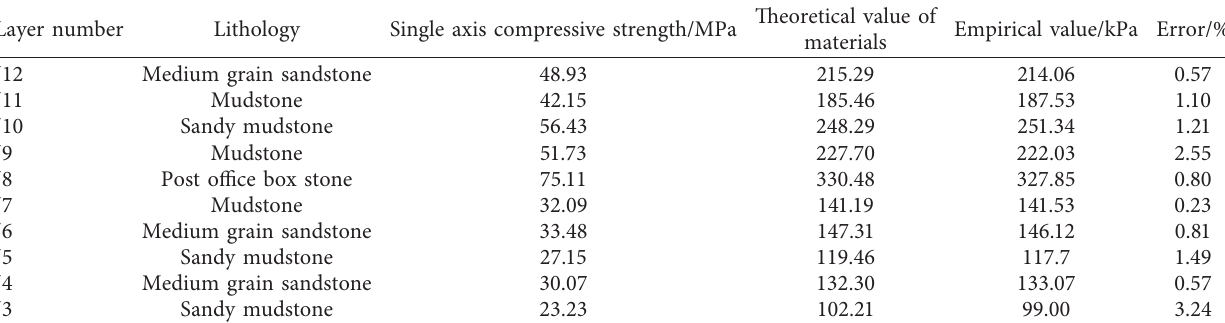
Table 4: Results of uniaxial compressive strength of partially tested